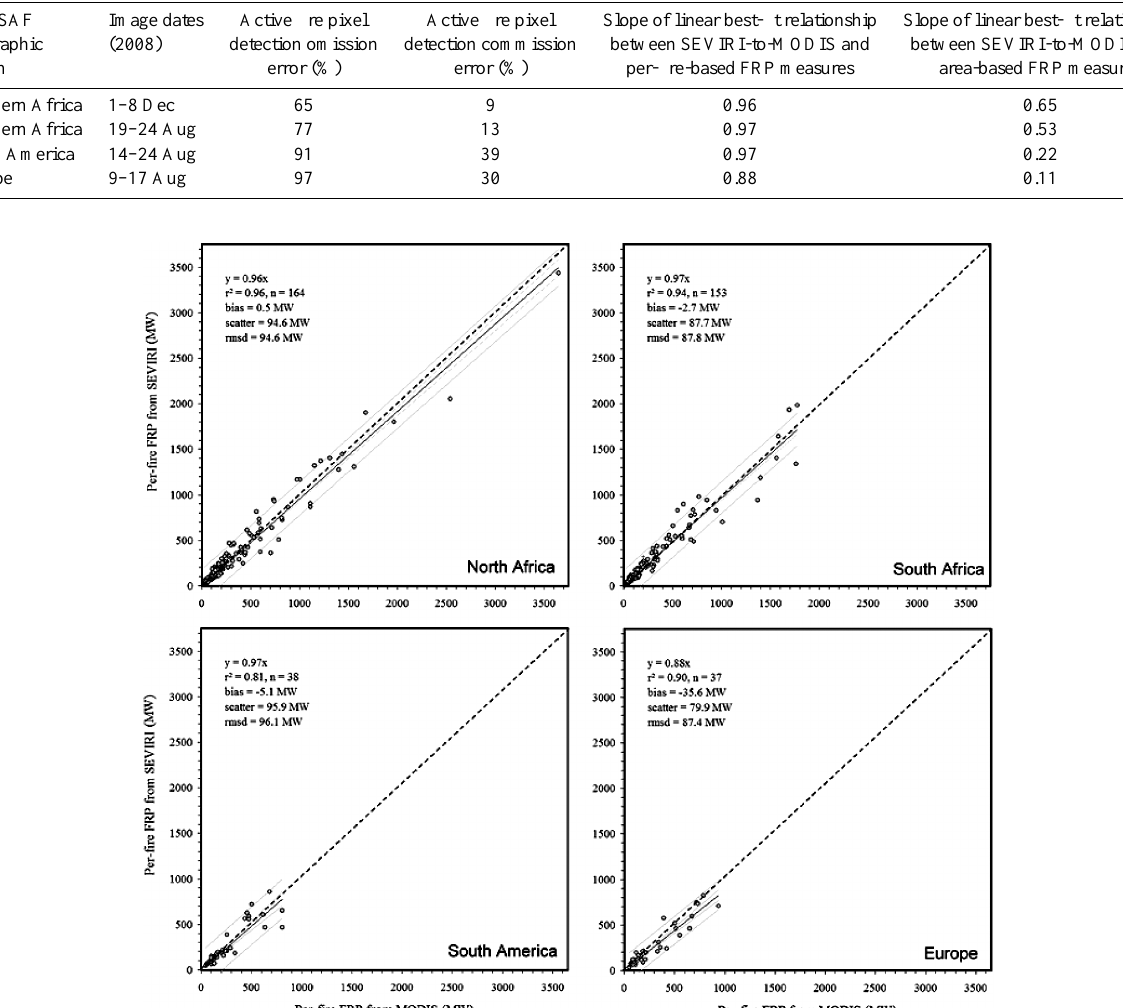
Table 1. Performance characteristics of the LSA SAF Meteosat SEVIRI FRP-PIXEL product in the four LSA SAF geographical regions, as compared to the MODIS active fire products (Collection 5 MOD14 and MYD14) collected over the same area and at the same time. Errors of omission and commission with respect to MODIS were calculated on a per-fire-pixel basis as described in Sect. 3.1.1. The per-fire basis results (column 5) were obtained when comparing the total FRP retrieved from MODIS and SEVIRI for fires (defined as a spatially contiguous set of active fire pixels) detected by both sensors. The area-based results (column 6) were derived from comparison of the total FRP measured by all detected fires in a matching MODIS and SEVIRI image area and thus include the influence of non-detected low FRP fires by SEVIRI whilst the per-fire comparison results (column 5) do not.